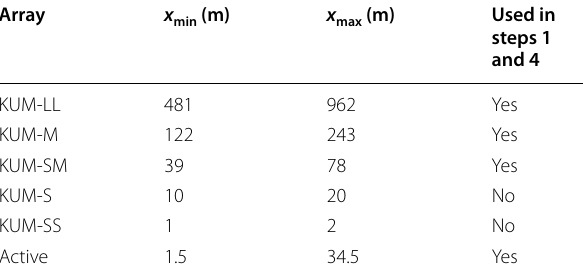
Table 1 Data sources; passive KUM nested arrays and active seismic line minimum and maximum inter-station distances